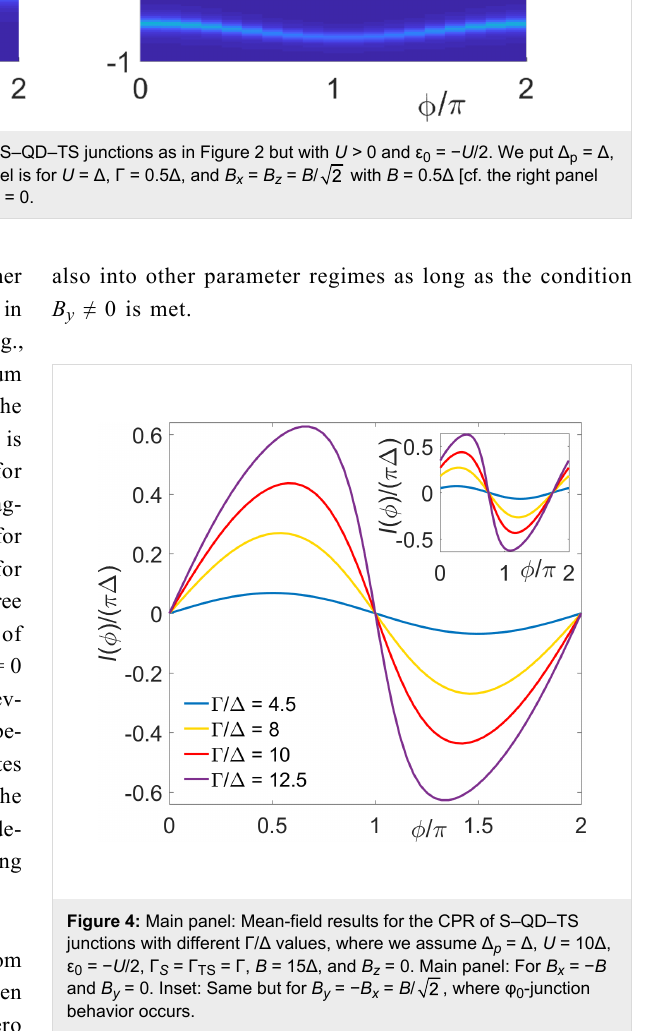
Figure 4: Main panel: Mean-field results for the CPR of S–QD–TS junctions with different Γ / Δ values, where we assume Δ p = Δ , U = 10 Δ , ε 0 = − U /2, Γ S = Γ TS = Γ , B = 15 Δ , and B z = 0. Main panel: For B x = − B and B y = 0. Inset: Same but for B y = − B x = B / , where φ 0 -junction behavior